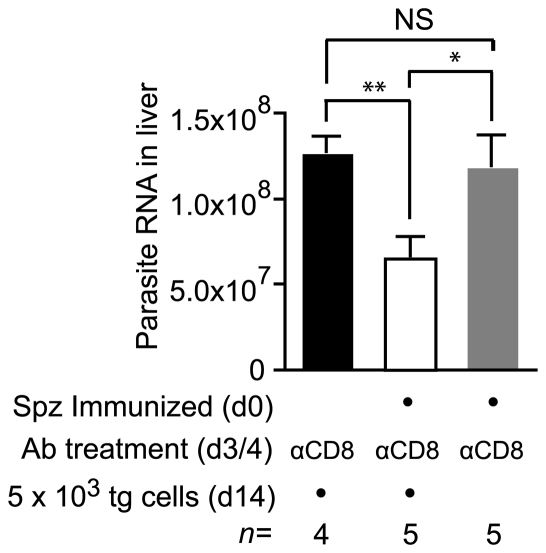
Cells primed weeks after immunization can inhibit parasite development.Two groups of mice were immunized with 3×104 irradiated sporozoites i.d. in the right ear on d0 and depleted of the endogenous CD8+ T cell response on days 3 and 4. Some of these mice received 2×103 transgenic cells on d14 (white bar) while others did not receive cells (gray bar). Naïve control mice were similarly depleted of CD8+ T cells on days 3 and 4 and received transgenic cells (black bar). All mice were then challenged on d21 and euthanized 40 hours later. Parasite burdens in the liver were measured by RT-PCR (mean ± SE, * = P<0.05, ** = P<0.01, data from one of two experiments shown).